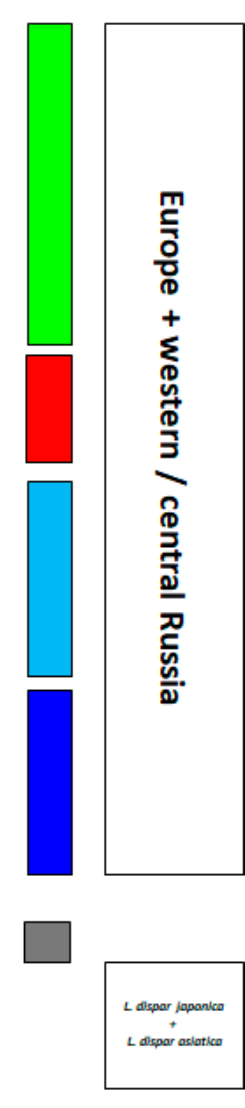
Figure 3. Bayesian reconstruction of molecular phylogenetic relationships among haplotypes of the current research supplemented with sequences submitted in GenBank (see text for detailed description). Numbers above nodes represent the Bayesian posterior probability with values greater than 0.6. Color of each bar is identical to the ones used in Figure 1.